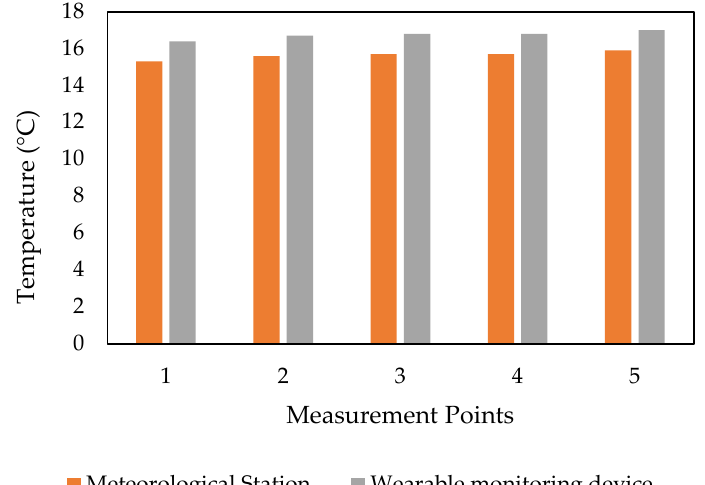
Figure 5. Temperature measurements comparison at points (1 to 5).